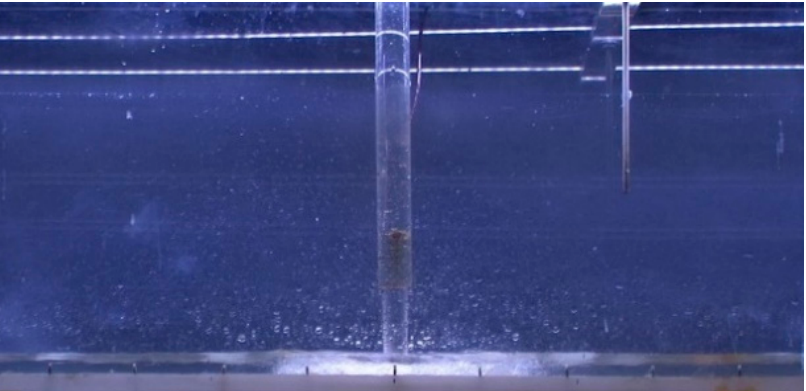
Figure 12. First seconds of filling an empty tundish, using the “Spheric” impact pad.